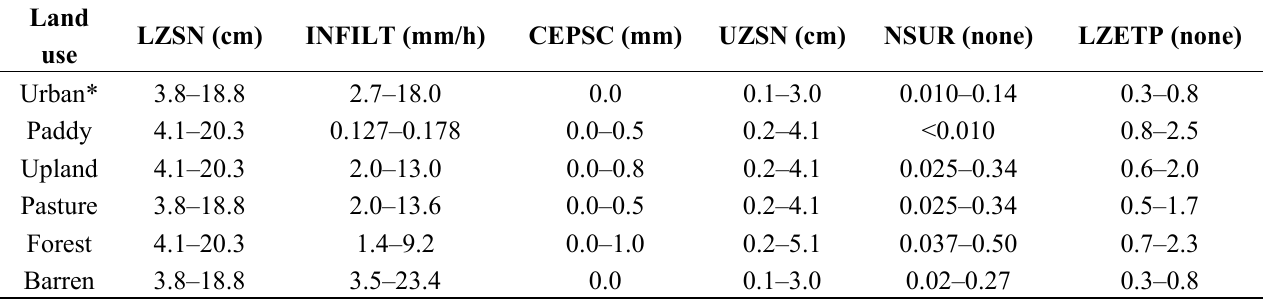
Table 3. Parameter ranges for land use